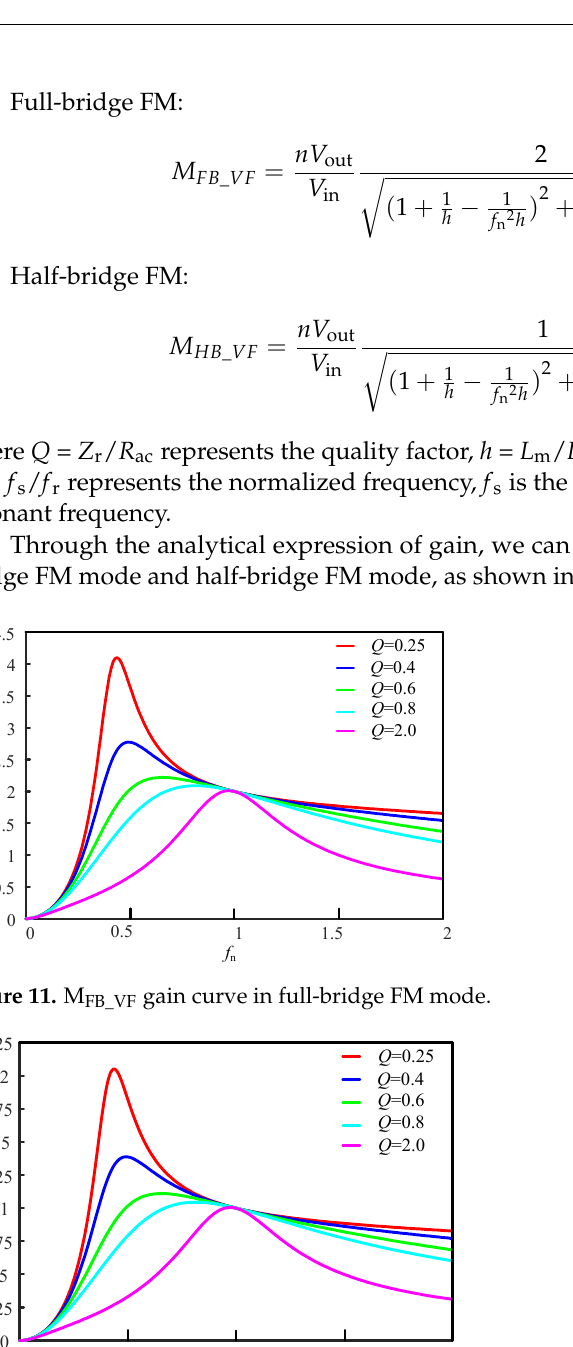
Figure 10. Equivalent circuit diagram of LLC resonant tank.